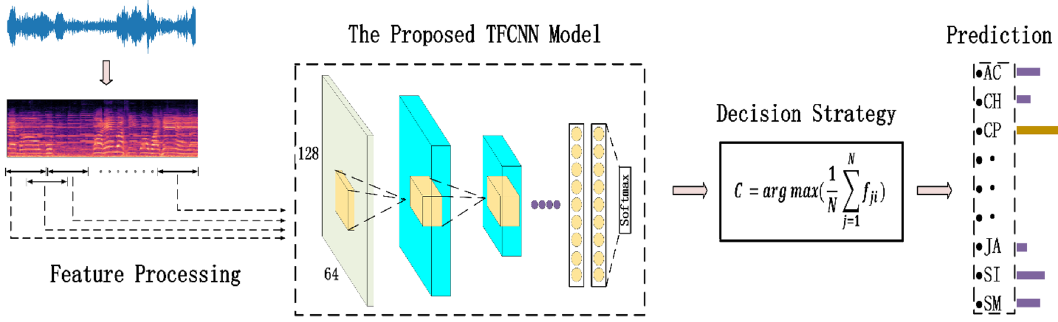
Figure 6. Probabilistic voting to predict the entire audio